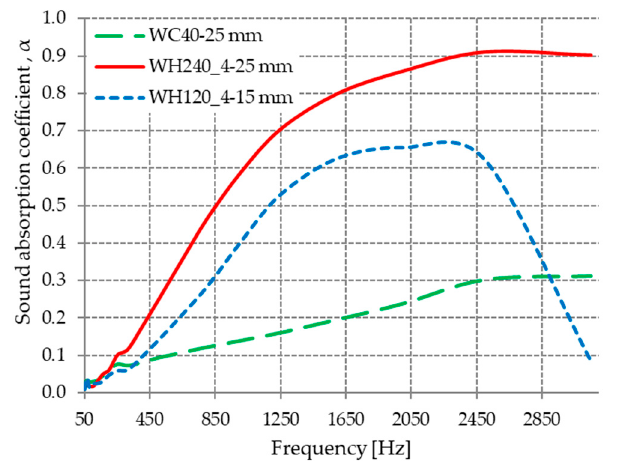
Figure 10. Variation in the acoustic absorption coefficient with frequency.